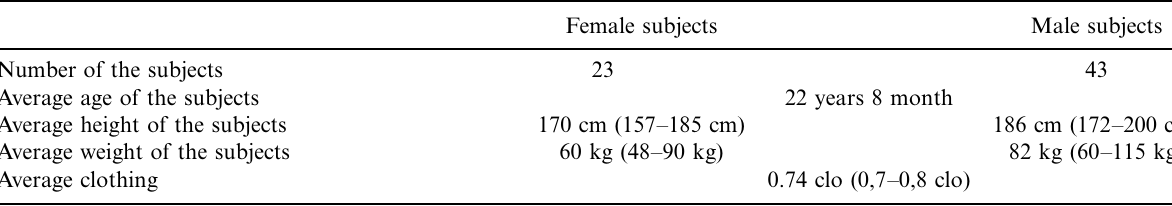
Table 1. Data of the subjects participated in the